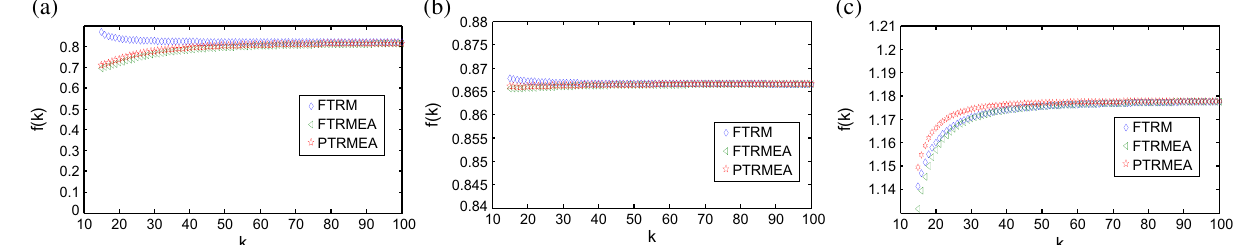
Figure 2. The asymptotic rate of convergence of fully-immersed 1DOF milling process at the parameter points (a) X = 5000 and w = 0.0002 m (stable operation), (b) X = 20000 and w = 0.001 m (stable operation) and (c) X = 20000 and w = 0.002 m (unstable operation). It is seen that partial averaging does not diminish rate of convergence much. It is also seen that PTRMPA is always slightly more convergent than FTRMPA and thus advocated.